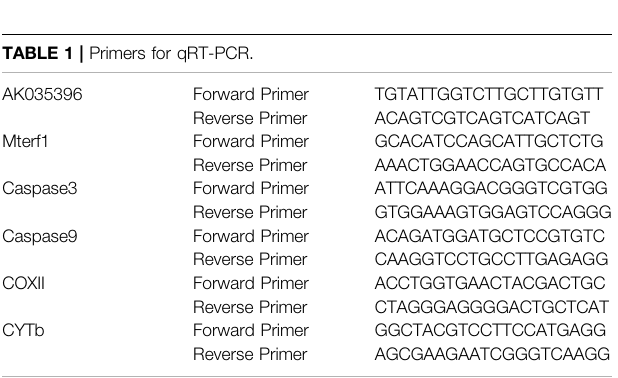
TABLE 1 | Primers for